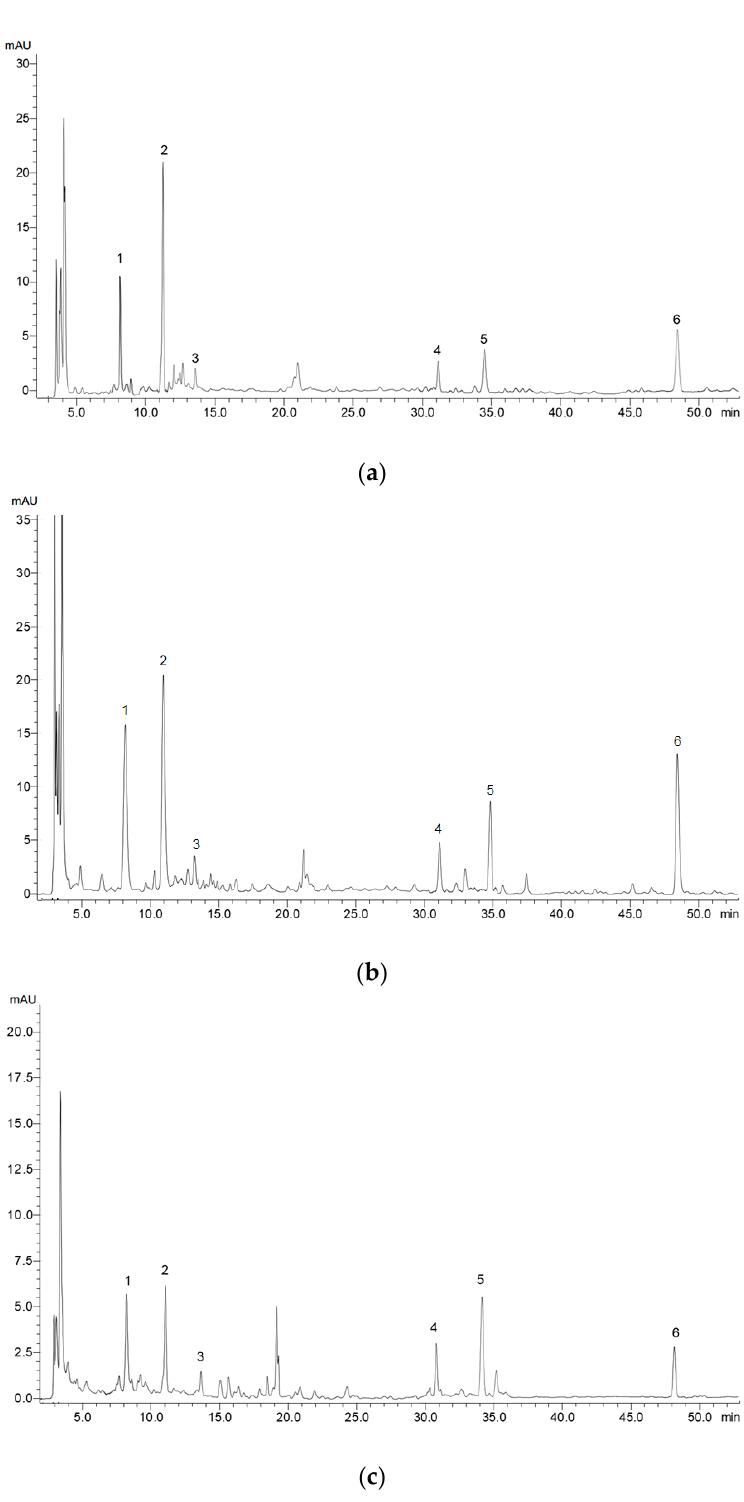
Figure A1. Exemplary HPLC chromatogram of the phenolic acids and flavonoids in ( a ) stems, ( b ) leaves, and ( c ) fruits of mistletoe ( Viscum album L) harvested from B. pendula . 1—neochlorogenic acid; 2—chlorogenic acid; 3—caffeic acid; 4—isorhamnetin; 5—kaempferol derivative; 6—quercetin derivative.